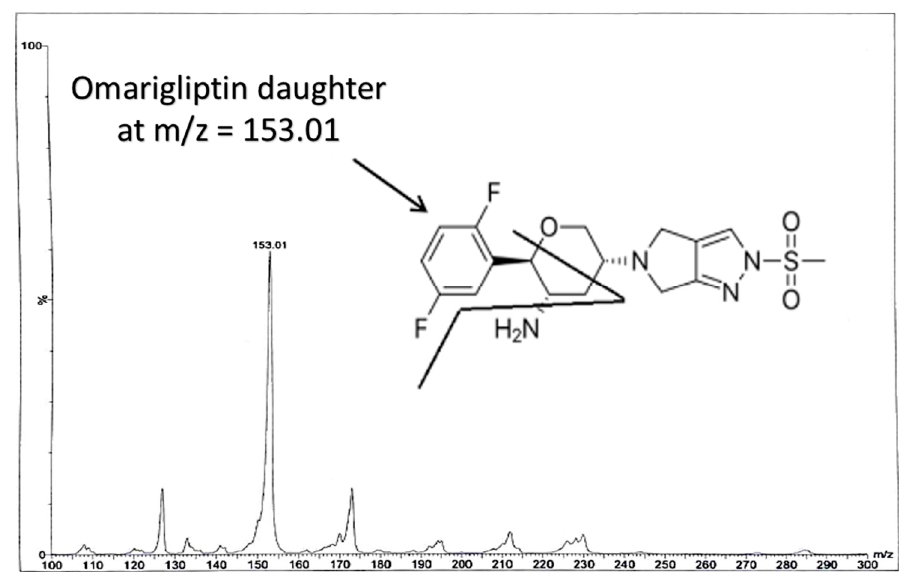
Figure 2. Chemical structure of alogliptin (IS) and its full scan mass spectrum.